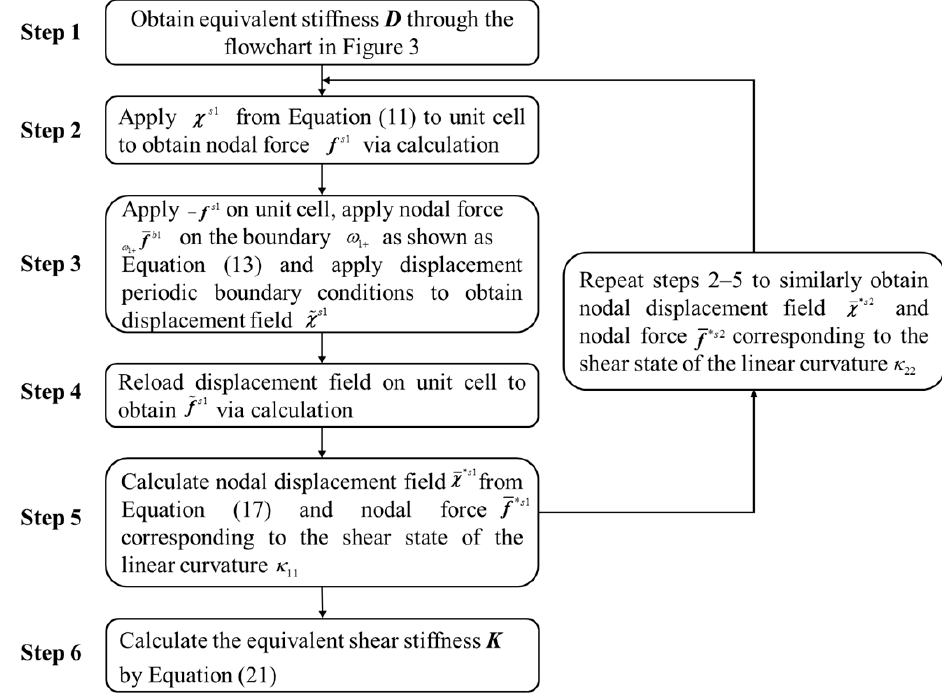
Figure 5. Flowchart of S-NIAH method to solve equivalent shear stiffness.